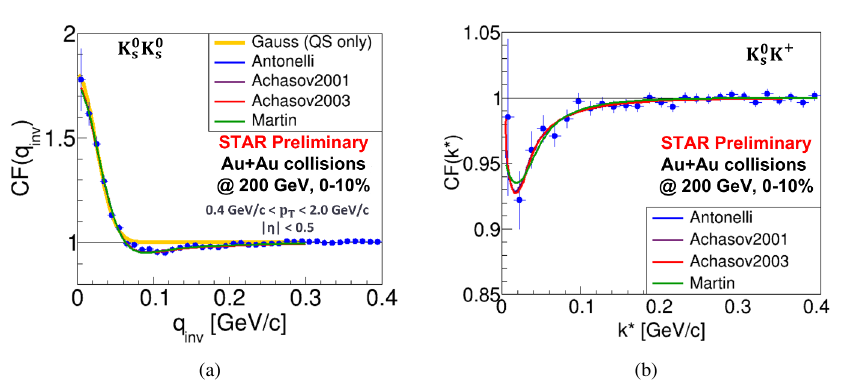
theoretical fits with the Lednicky-Lyuboshitz parametrization.